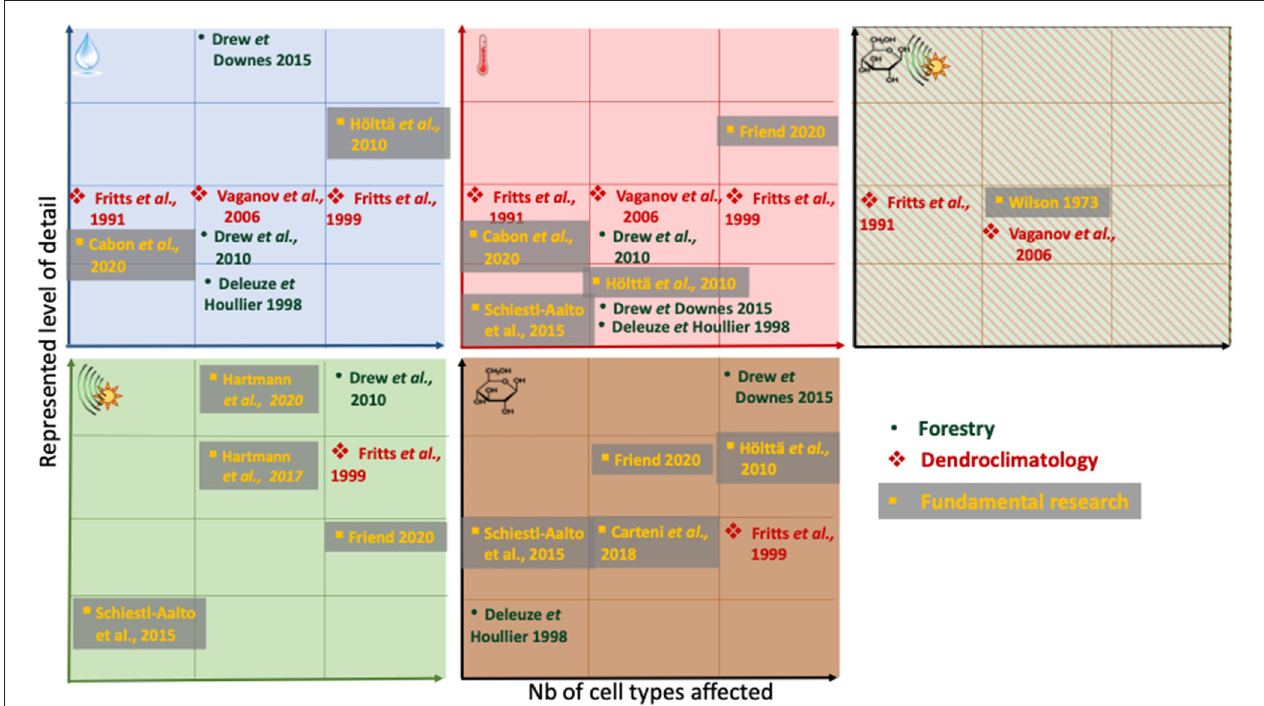
FIGURE 3 | Schematic of environmental and tree-internal drivers and regulators represented in the wood formation models discussed in this paper. Drivers reported are (top-left to bottom-right) water, temperature, either daylength (phenological) signal or carbon, hormonal/daylength (phenological) signal, carbon (note the absence of nutrients as growth rate modifiers in all models). The positioning along the axes within each box reflects (1) the number of cell types affected by an external/internal driver and (2) the level of detail driver-cell interactions are resolved. Left to right: First square: one cell type is affected only (this could be e.g., cambial cells or wall thickening cells only), last square: all three cell types are affected. Bottom to top: low level of complexity with which an environmental driver influences the model e.g., as single part of a physical equation (e.g., through a threshold parameter to promote an on-off switch environmental switch (e.g., assume metabolic activity occurs only above 5 ◦ C (Deleuze and Houllier, 1998))) next square: as part of a response-function e.g., increasing enlargement rate with temperature (Fritts et al., 1991; Friend, 2020 ). Complexity can increase even further to a detailed physiological level, for example through spatial interactions e.g., diffusion of carbon across the developing radial file, followed by arriving carbon being included into the thickening cell wall, as sort of done in Friend (2020). Note that for Schiestl-Aalto et al. (2015), we interpret the “ontogenetic development” used as one the modifiers of cell proliferation dynamics by the authors, as an internal signal, and therefore place it in the bottom-left square, as a hormonal/daylength (phenological) signal. If a model is absent from an environmental factor matrix, it does not resolve this particular environmental factor. Within the squares, no ranking is attempted. Note that the relative position along the y-axis is not comparable between the environmental /internal factors. Note that this is a rough scheme, derived from text-descriptions and equations in the publications, which sometimes may not represent the entirety or complexity of an operation in the model itself. Only the latest version of Treerings (Treerings3) is shown